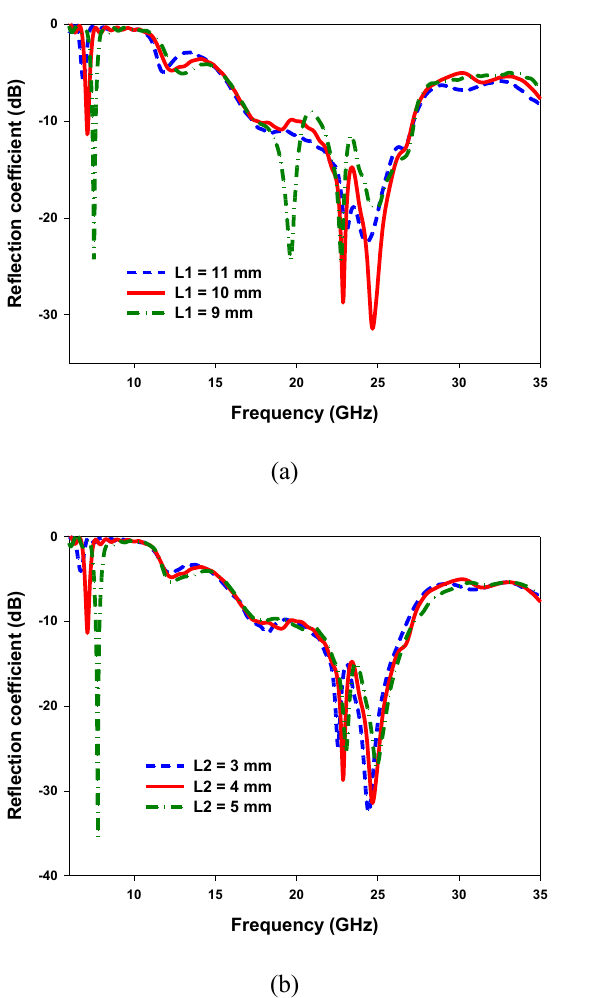
FIGURE 5. Reflection coefficient for various values of (a) L3 and (b) L4 lengths of L_slot 2. The effect of position “D” and width “W” of Slot 3 on the reflection coefficient are shown in Fig. 6. The D parameter is changed from 2.3 mm to 4.3 mm, the optimal value for D is founded to be 3.3 mm for the best adaptation at the first band 7.5 GHz (military satellite communication band). Decreasing the D parameter leads to a reduction in the resonant frequency of the second band. It is worth noting from Fig. 6 (a) that the variation of D parameter have no effect on the resonance frequency of 28 GHz. D=3.3 mm is kept and W is varied from 0.5 to 1.5 with a 0.5 mm step as shown in Fig. 6 (b) and it is noticed that as W increases the frequency of the second band also increases. The optimal value is W=1 mm, which corresponds to 9 GHz (Radar